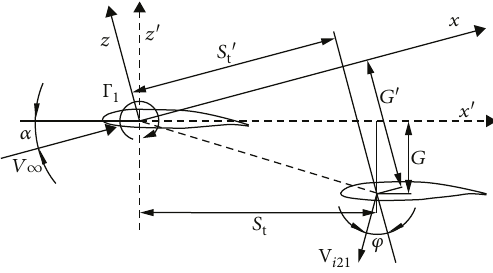
Figure 2: Relationship between the direction of the induced velocity and the z